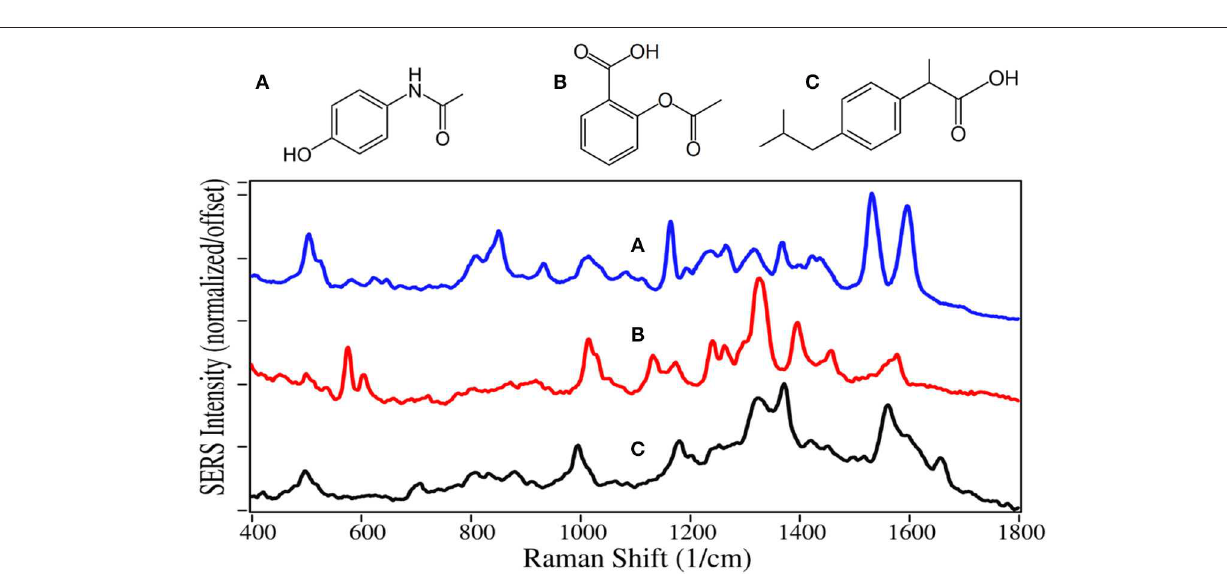
Frontiers in Chemistry |